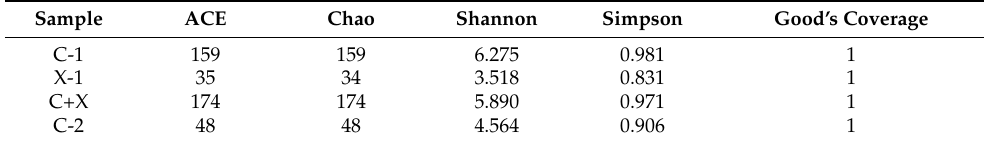
Table 2. Statistics of α -diversification of